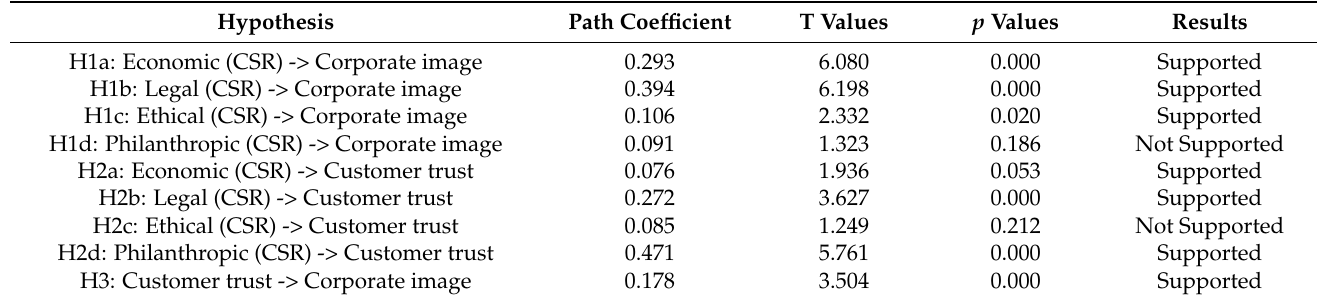
Table 4. Hypotheses results for Model